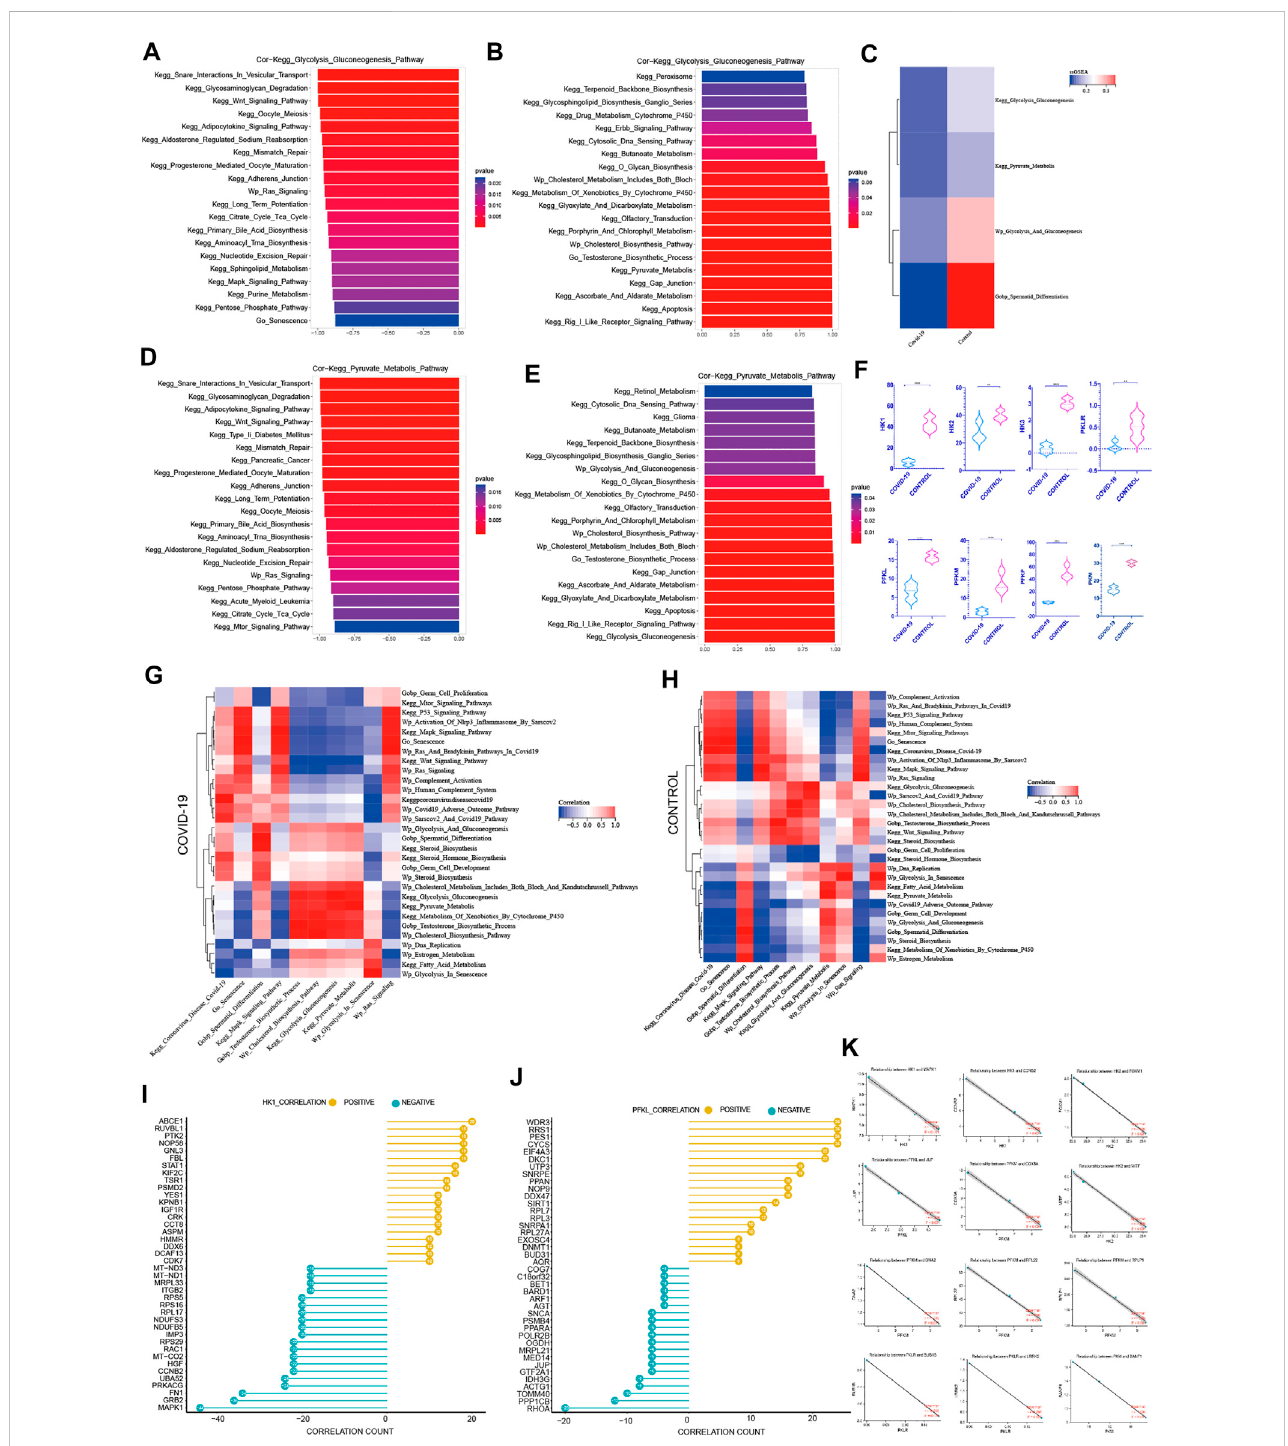
FIGURE 5 The negative correlation between cellular senescence with pyruvate and lactate generation (A) The top 20 pathways in COVID-19 were signi fi cantly negatively correlated with Kegg Glycolysis Gluconeogenesis, among which Go Senescence pathway was the most relevant ( r = − .874, p < .001). (B) The top 20 pathways in COVID-19 were signi fi cantly positively correlated with Kegg Glycolysis Gluconeogenesis, which were mainly concentrated in the saccharometabolism-related pathways. (C) ssGSEA score of Kegg Glycolysis Gluconeogenesis, Kegg Pyruvate Metabolis, Wp Glycolysis And Gluconeogenesis decreased in COVID-19. (D) The top 20 pathways in COVID-19 were signi fi cantly negatively correlated with Kegg Pyruvate Metabolis, among which GoSenescence pathway wasthemostrelevant ( r = − .93, p < .001). (E) The top 20 pathways inCOVID-19 weresigni fi cantlypositivelycorrelated with Kegg Pyruvate Metabolis. (F) These three glycolytic rate-limiting enzymes decreased in COVID-19 infection (HK, PFKL, PKLR and their isoenzymes). (G) The correlation of Kegg Glycolysis Gluconeogenesis, Kegg Pyruvate Metabolis with GO gene sets, KEGG pathways, and WIKIPATHWAYS pathways in COVID- 19 group. (H) The correlation of Kegg Glycolysis Gluconeogenesis, Kegg Pyruvate Metabolis with GO gene sets, KEGG pathways, and WIKIPATHWAYS pathways in the Control group. (I) The top 20 genes strong negative correlation with HK1 ( r < − .9, p < .05) by PPI and the top 20 genes strong positive correlation with HK1 ( r > .9, p < .05) by PPI. (J) The top 20 genes strong negative correlation with PFKL ( r < − .9, p < .05) by PPI and the top 20 genes strong positive correlation with PFKL ( r > .9, p < .05) by PPI. (K) Several genes implicated in cell senescence are among the top 20 genes negatively correlated with HK1, PFKL or